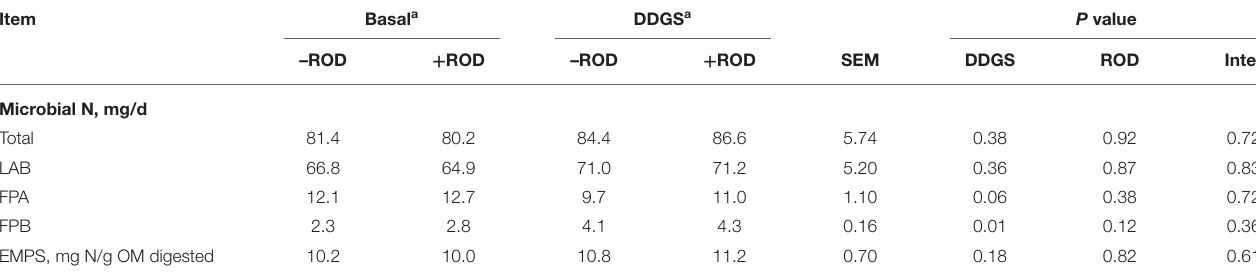
EMPS, mg N/g OM digested